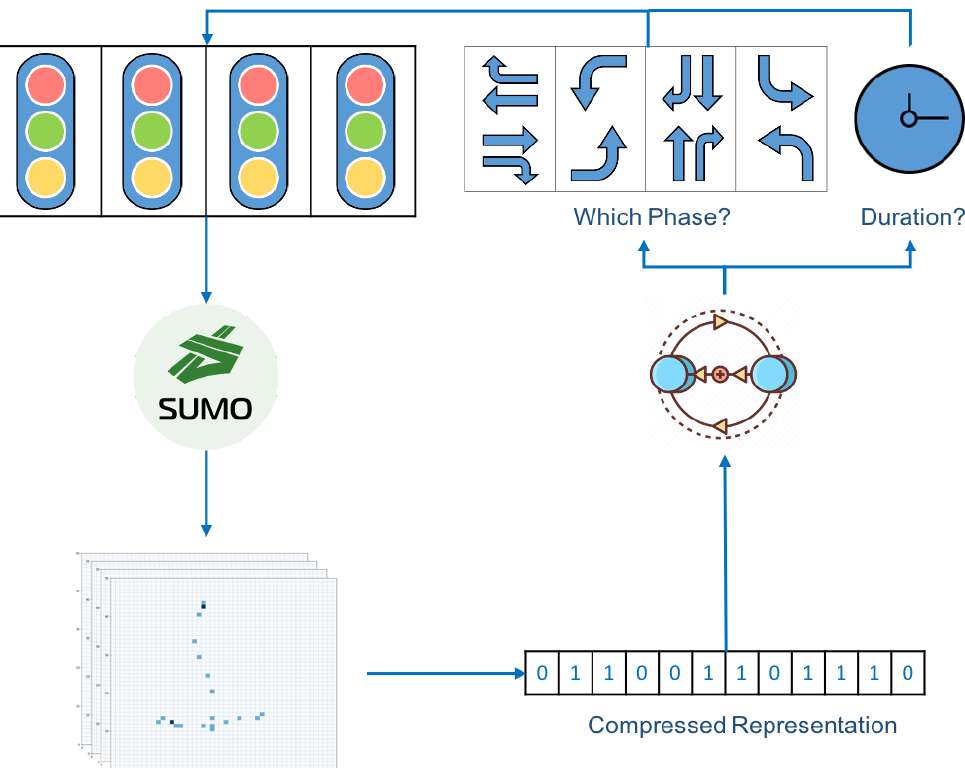
Figure 7. Proposed deep reinforcement learning